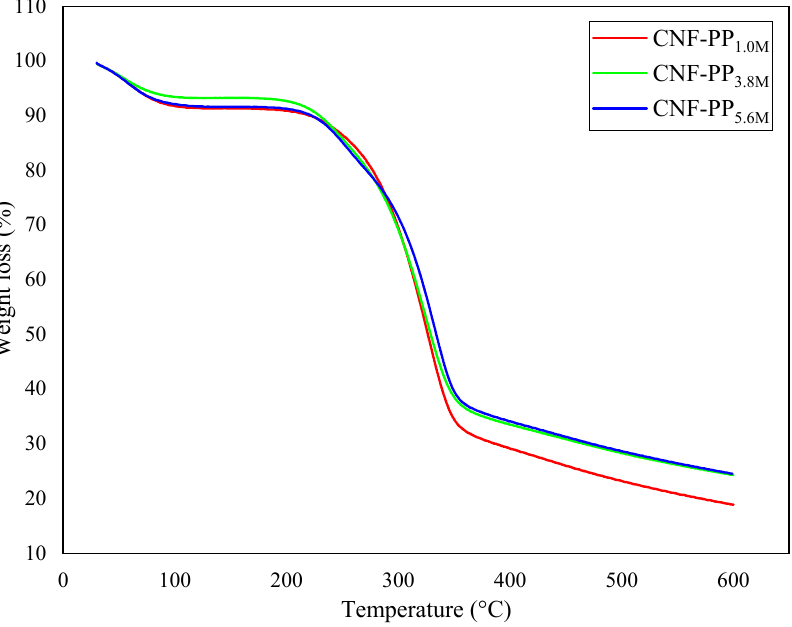
Figure 5. TGA curves of CNF-PP 1.0M , CNF-PP 3.8M and CNF-PP 5.6M .